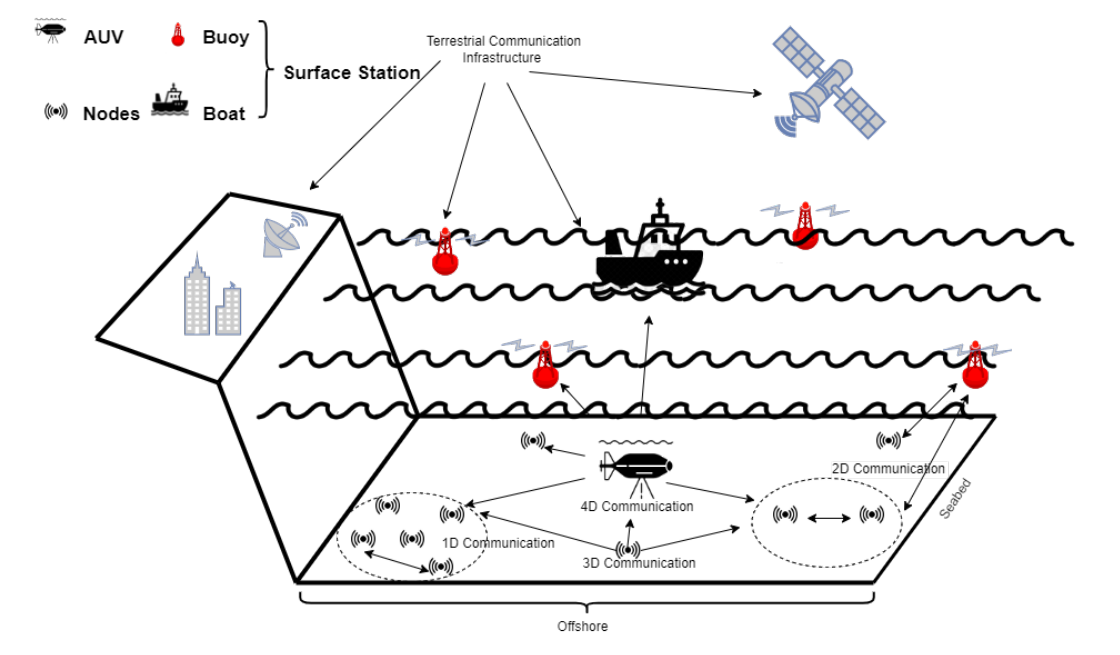
Figure 1. Architecture of underwater wireless sensor